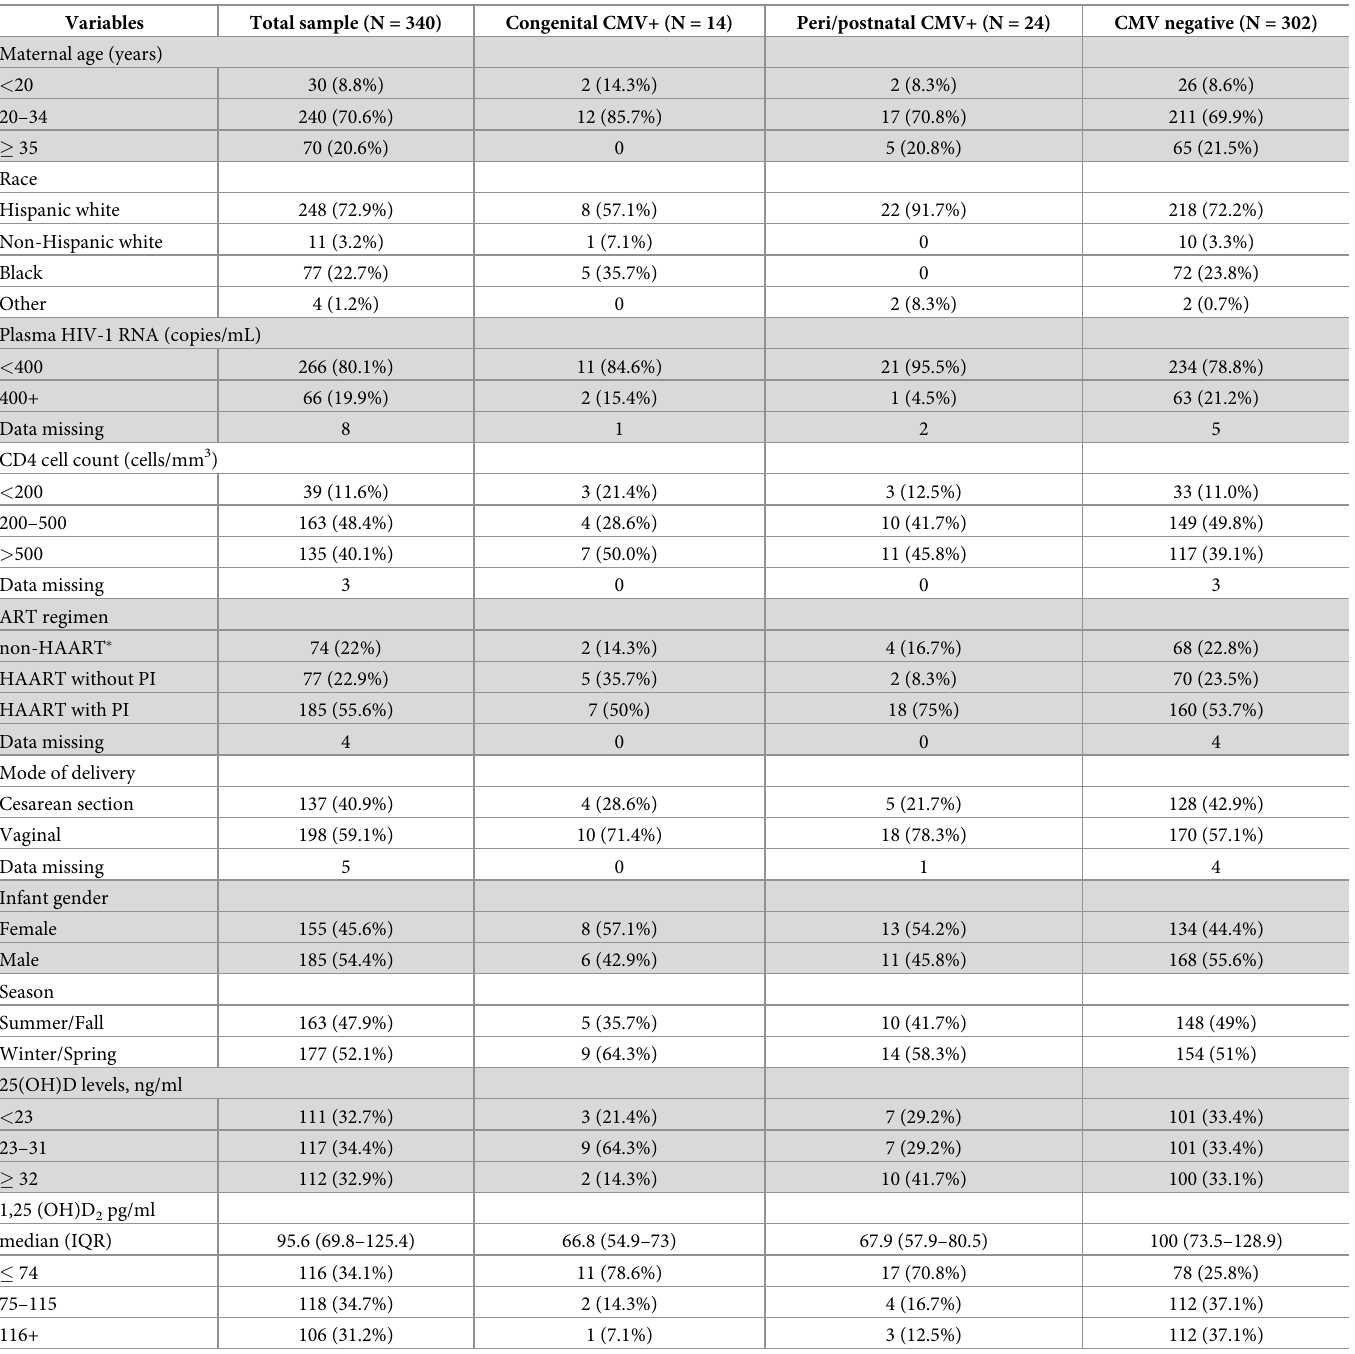
Table 1. Study cohort